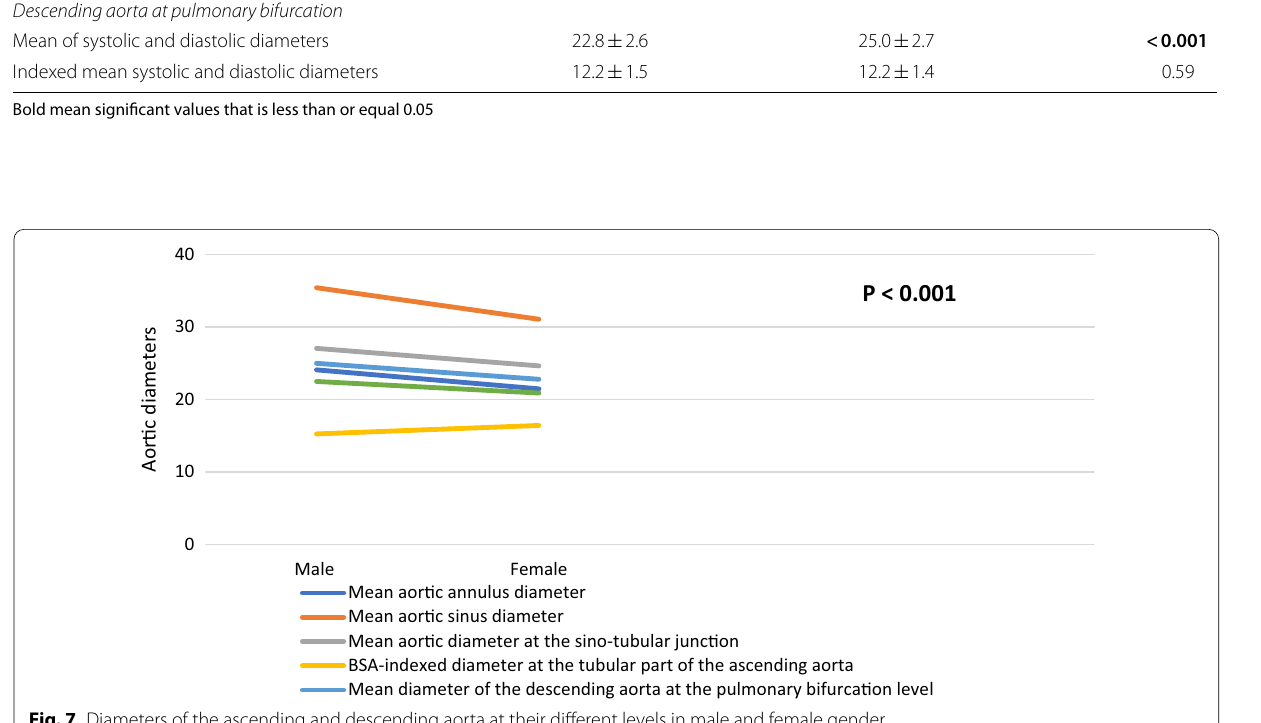
Fig. 7 Diameters of the ascending and descending aorta at their different levels in male and female gender